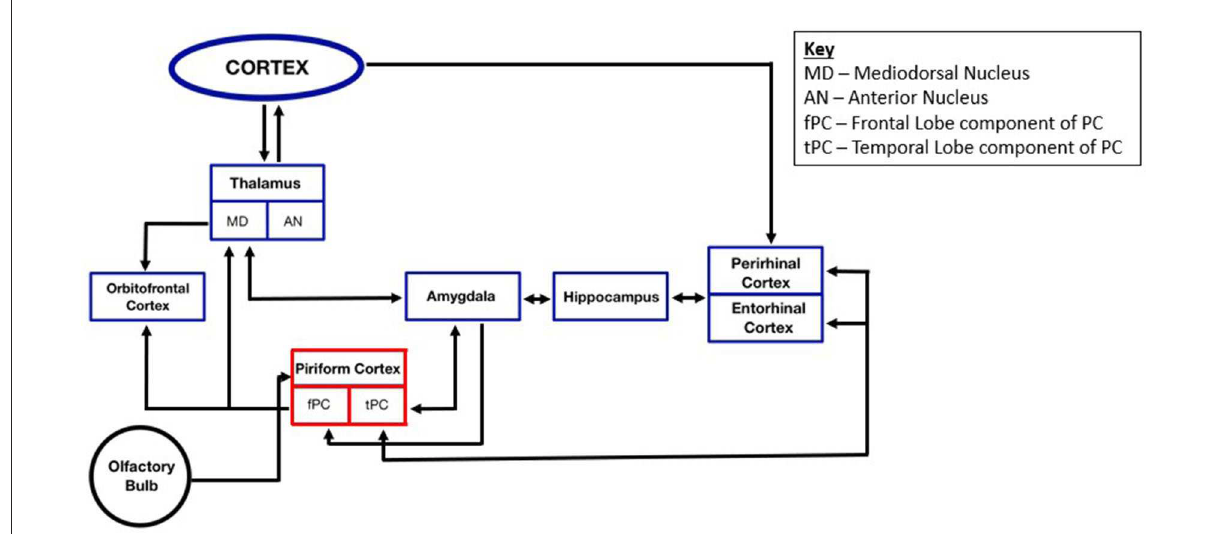
FIGURE2 Functional overview of piriform cortex connectivity within the temporal lobe epilepsy seizure